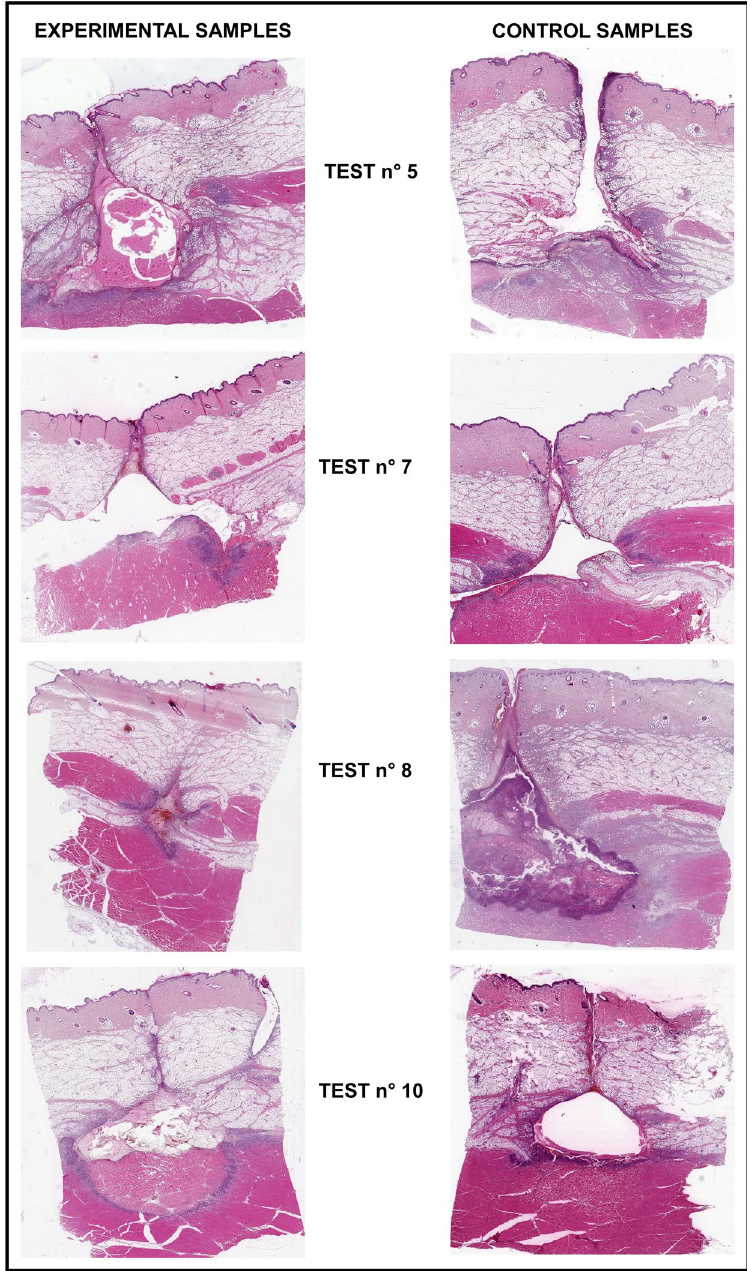
Figure 5. Macrophotographs of the wound specimens treated with the electro-pneumatic device (i.e. experimental samples) at left side, and the non-treated specimens (i.e. control samples) at